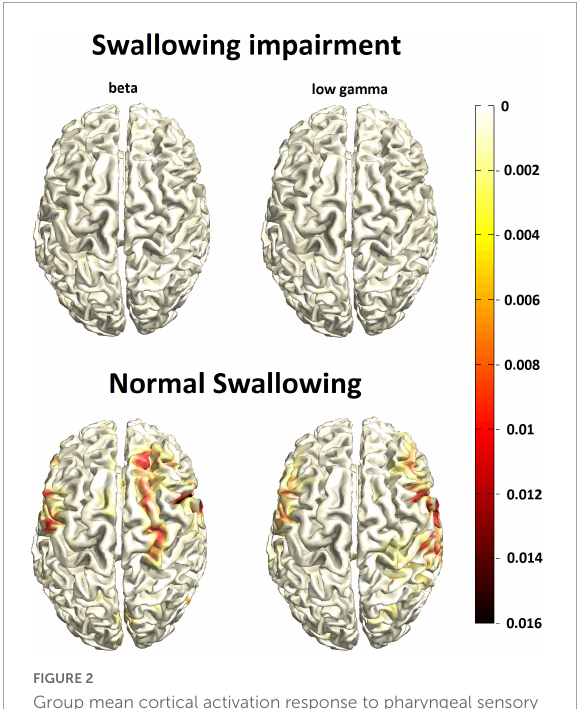
FIGURE2 Group mean cortical activation response to pharyngeal sensory stimulation (N = 27/group) in participants with swallowing alterations (top row) vs. normal swallowing function (bottom row). The color bar represents power changes relative to the resting